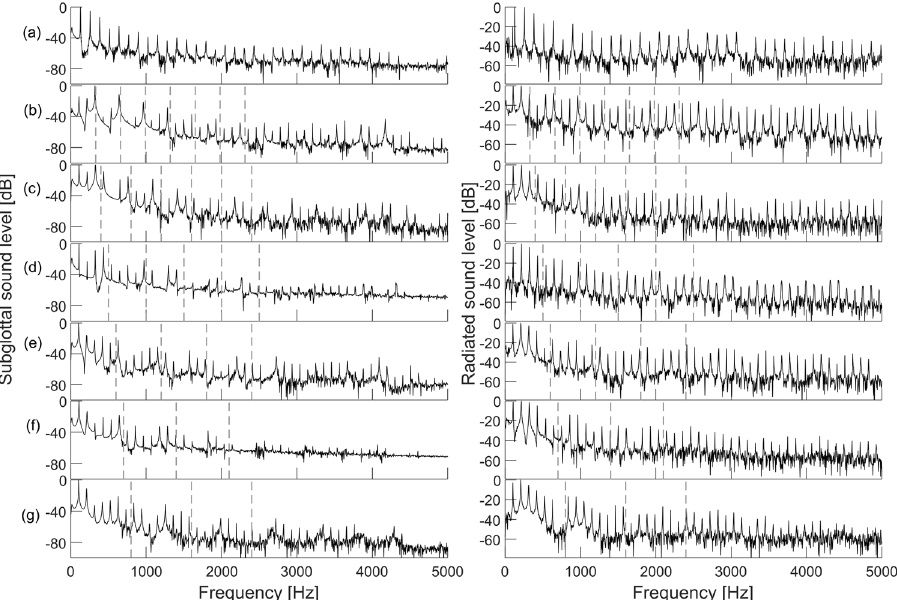
Figure 4. Spectra of the subglottal (left) and radiated (right) sounds, corresponding to the waveforms shown in Fig. 3. The subglottal settings were: ( a ) anechoic subglottal tract, ( b ) f R1 = 330 Hz, ( c ) f R1 = 400 Hz, the frequency resolution of 4 Hz and were normalized by calculating the maximum value in each spectrum and setting it to 0 dB.